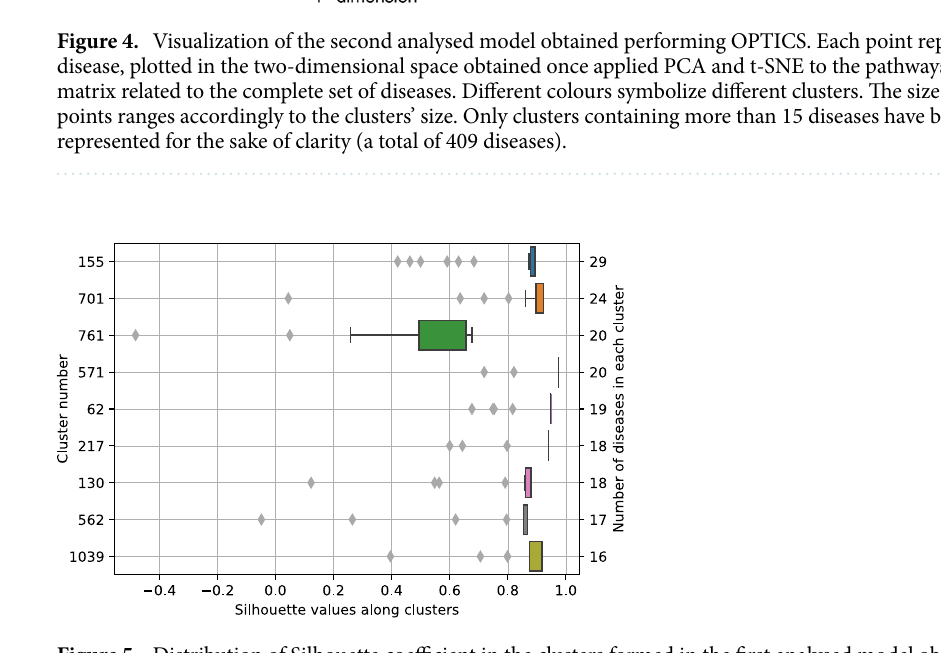
Figure 5. Distribution of Silhouette coefficient in the clusters formed in the first analysed model obtained performing OPTICS. Only the 9 first largest clusters are shown, depicted sorted by the number of diseases (cluster 165 has 29 diseases while cluster 1043 has 16 diseases). The specific diseases grouped inside each cluster can be found at the public